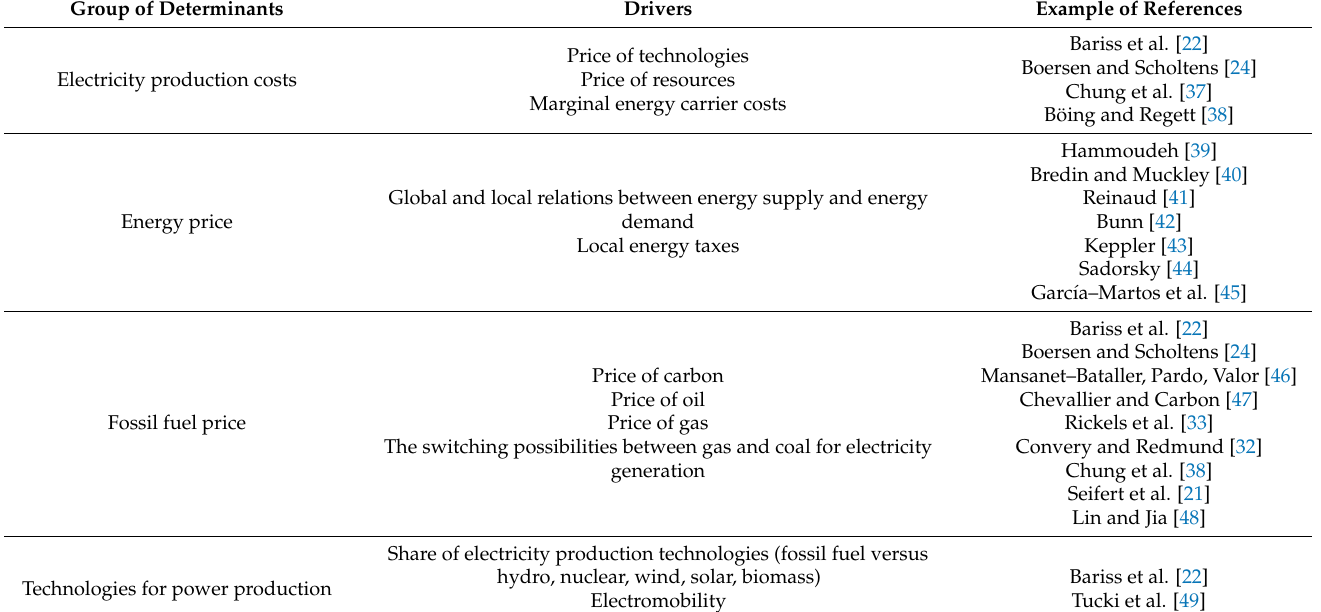
Table 3. Determinants and drivers of the CO 2 emission allowances price according to conducted literature review. Group of